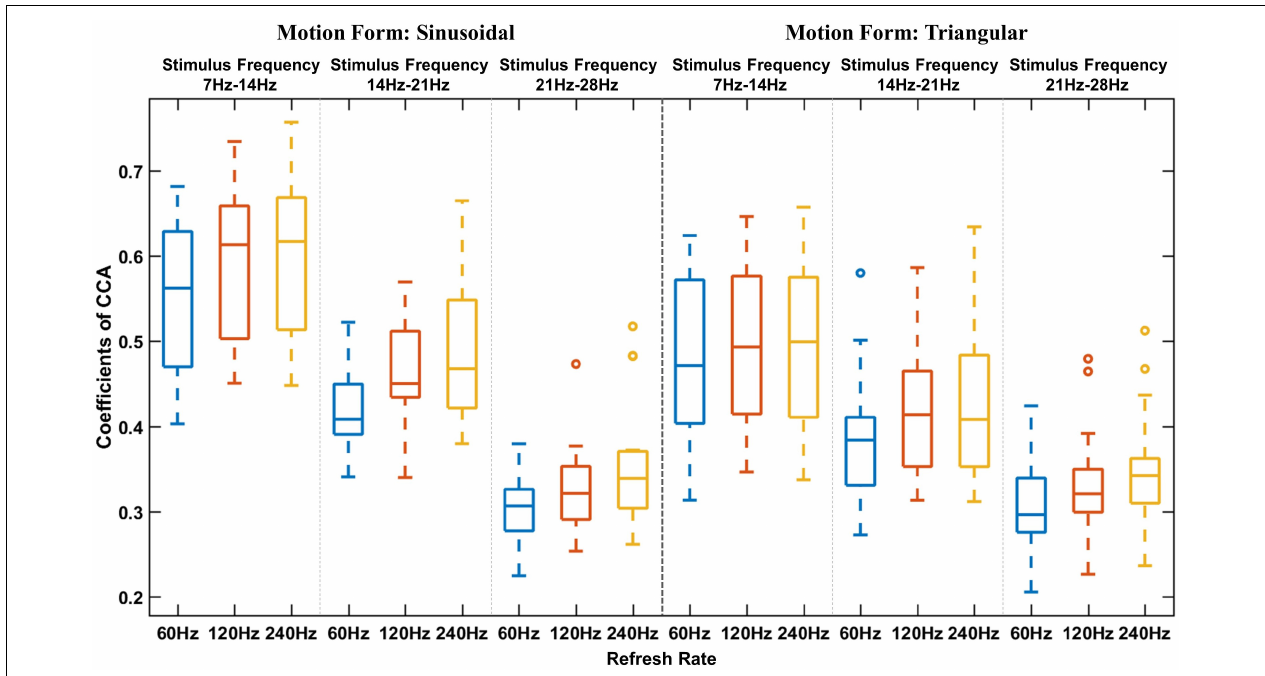
FIGURE 5 | Average stimulation response boxplot of different frequencies. The horizontal axis indicates the refresh rate, and the vertical axis indicates the average CCA coefficient. The black dotted line is used to separate different motion forms, and the blue dotted line is used to separate different stimulation frequencies.